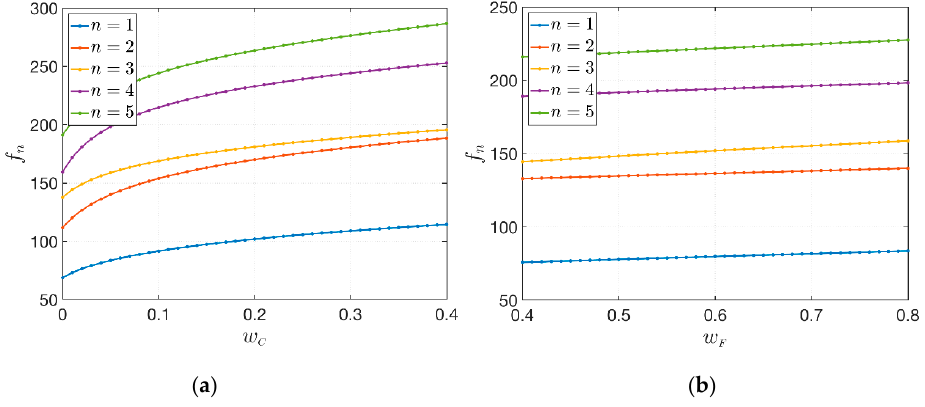
Figure 9. Variation of the first five natural frequencies f n [Hz], for n = 1, ... ,5, of sandwich plates with a damaged soft-core for varying mechanical properties of the constituents: ( a ) Variation of CNT mass fraction; ( b ) Variation of fiber mass fraction.